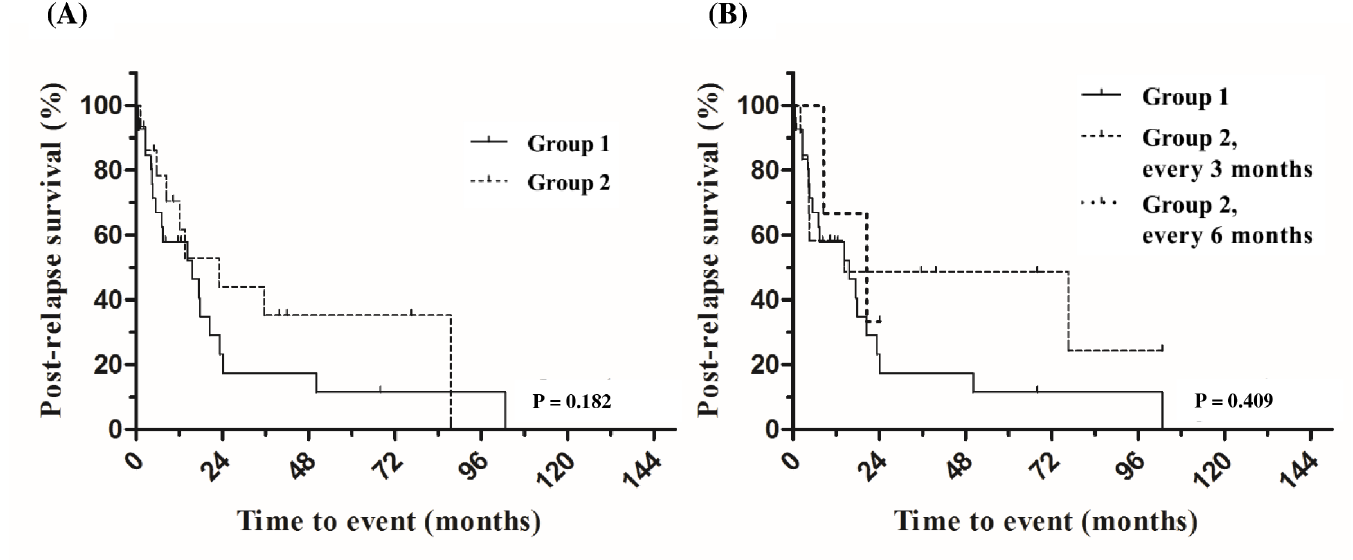
Fig 4. Kaplan-Meier curves of post-relapse survival in relapsed aNHL patients after achieving complete remission with salvage chemotherapy. Post-relapse survival according to (A) relapse detection method and (B) surveillance CT interval among patients who relapsed after achieving complete remission with salvage therapy. Group 1: Relapse detected by a method other than CT (symptoms, physical examination, or blood tests). Group 2: Relapse detected by surveillance CT.